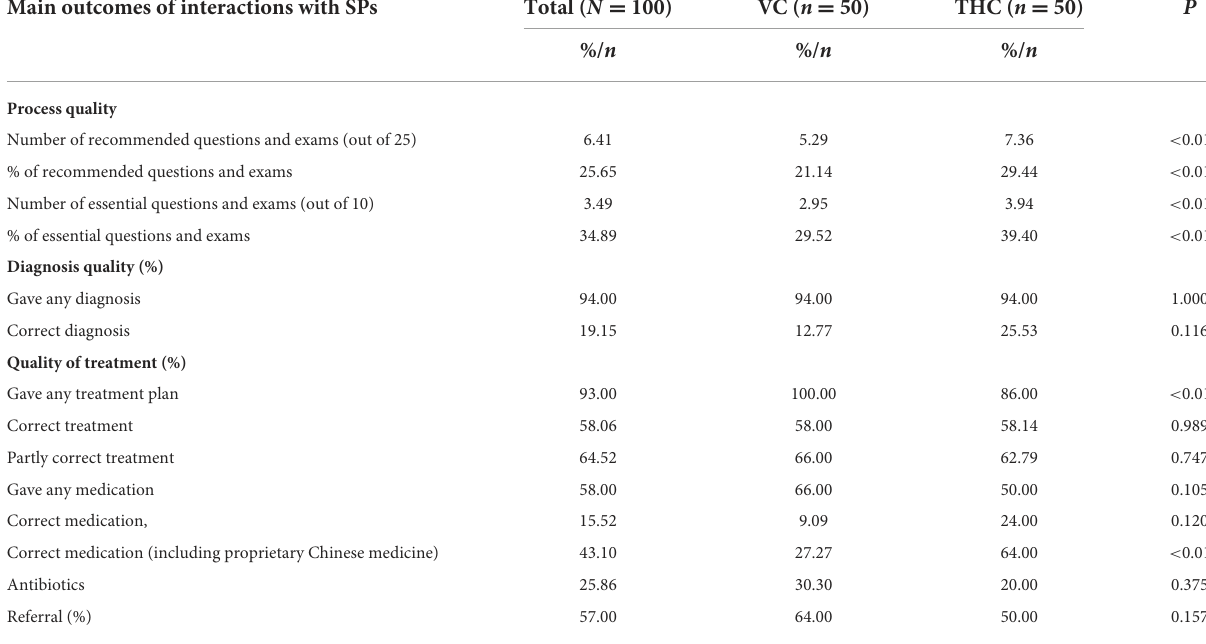
TABLE 5 Main outcomes of interactions with Standardized Patients (SPs) for angina.